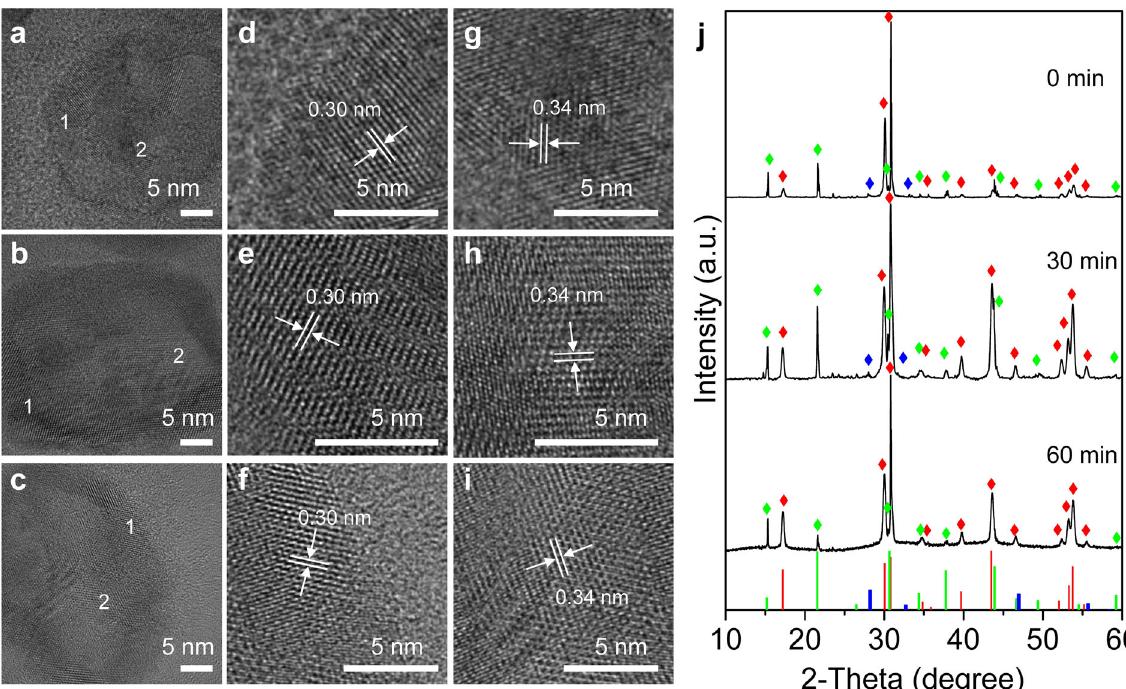
Fig. 4 Structural analysis of CsPbBr 3 -NaYF 4 :Yb,Tm hybrid nanocrystals. HRTEM images of heterostructured CsPbBr 3 -NaYF 4 :Yb,Tm nanocrystals collected during the synthesis after heated at 300 °C for different time: a 0 min, b 30 min, c 60 min. d – f Enlarged images of region 1 in a , b , and c , respectively. g – i Enlarged images of region 2 in a , b , and c , respectively. j X-ray diffraction (XRD) patterns of the three samples. Hexagonal NaYF 4 ,